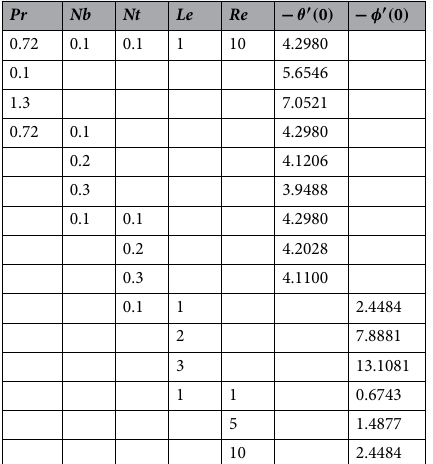
θ ′ ( 0 ) and Sharwood number −